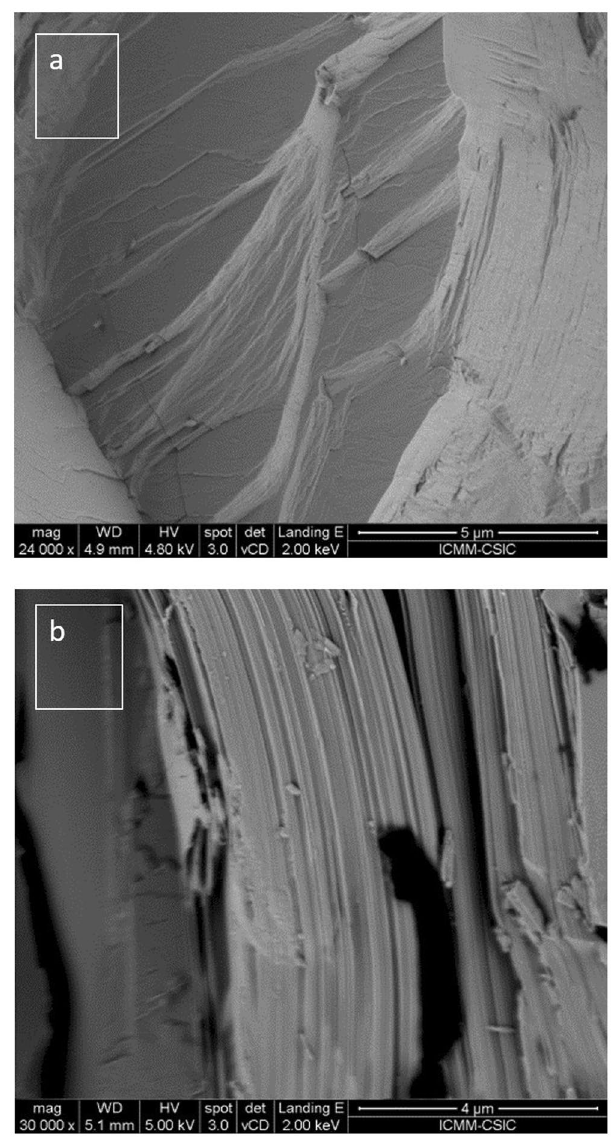
Figure 4. Scanning electron microscopy (SEM) images of as-grown Bi 0.5 Sb 1.5 Te 3 at ( a ) x24000 and ( b ) x30000 magnification. The samples are made up of nanometric platelets (less than 50 nm thick) normal to the